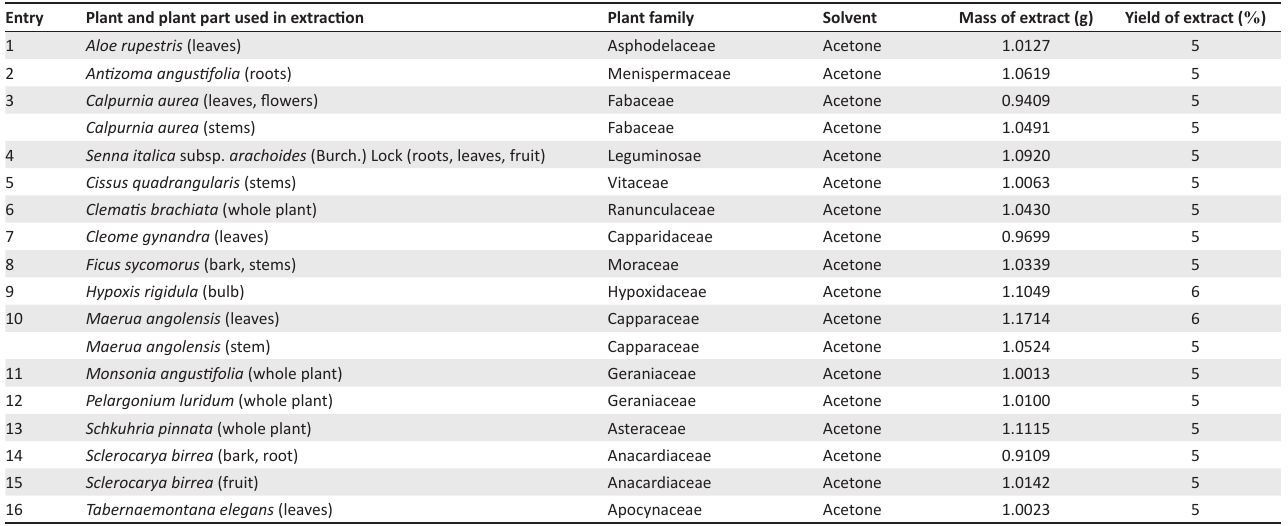
TABLE 1: The plant and plant part used for the solvent extraction, plant family, solvent, the mass and percentage yield of extract